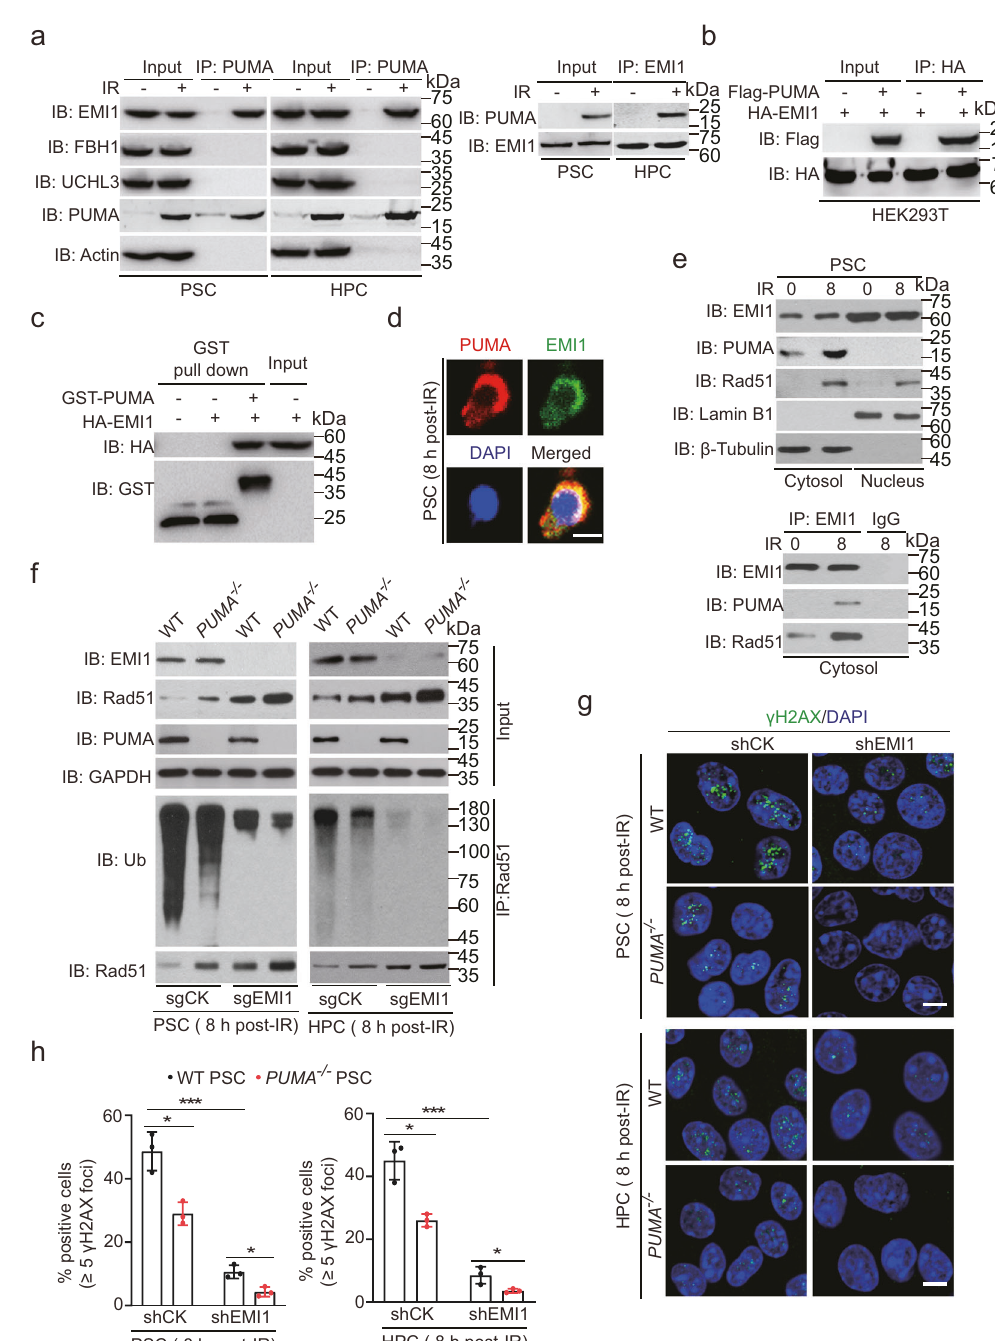
Fig. 4 PUMA interacts with cytoplasmic Rad51 and EMI1. a IP and IB of PUMA interaction with EMI1, FBH1, and UCHL3 in PSCs and HPCs with or without IR. b IP and IB of PUMA interaction with EMI1 in HEK293T cells. c In vitro GST pull-down analysis. Puri fi ed GST-PUMA or GST proteins were mixed with cell extracts from PSCs. d Representative images of colocalization of PUMA and EMI1 in PSCs at 8 h post-IR. DAPI was used to show nucleus. An anti-EMI1 antibody (JG35-83, #NBP2-76833, Novus Biologicals) was used. Scale bars, 5 μ m. e IP and IB of EMI1 interaction with cytosolic PUMA and Rad51 in PSCs with or without IR. f Effects of EMI1 KO with a sgRNA on PUMA-mediated Rad51 ubiquitination in PSCs and HPCs after IR. g Representative images of γ H2AX foci in PUMA WT and KO PSCs or HPCs transduced with or without an EMI1 sgRNA after IR. Scale bars, 10 μ m. h Quanti fi cation of γ H2AX foci in g . The percentage of positive cells ( ≥ 5 γ H2AX foci) was shown. Data are representative of three independent experiments with similar results. Error bars, SD. * P < 0.05, *** P < 0.001 PUMA, and EMI1 may form a ternary complex and the F129A with or without PUMA in HEK293T cells, and revealed that the mutation may change the structure around the F129 residue to F129A mutation decreased Rad51 association with EMI1 and affect its association with PUMA and EMI1. We then performed PUMA promoted EMI1 association with Rad51 WT, but not the cytoplasmic and nuclear fractionation and found that F129A F129A mutant (Fig. 5f). In addition, the F129A mutation attenuated mutation inhibited EMI1-mediated cytosolic Rad51 ubiquitination EMI1 association with PUMA (Fig. 5g), suggesting that Rad51, Signal Transduction and Targeted Therapy (2021)